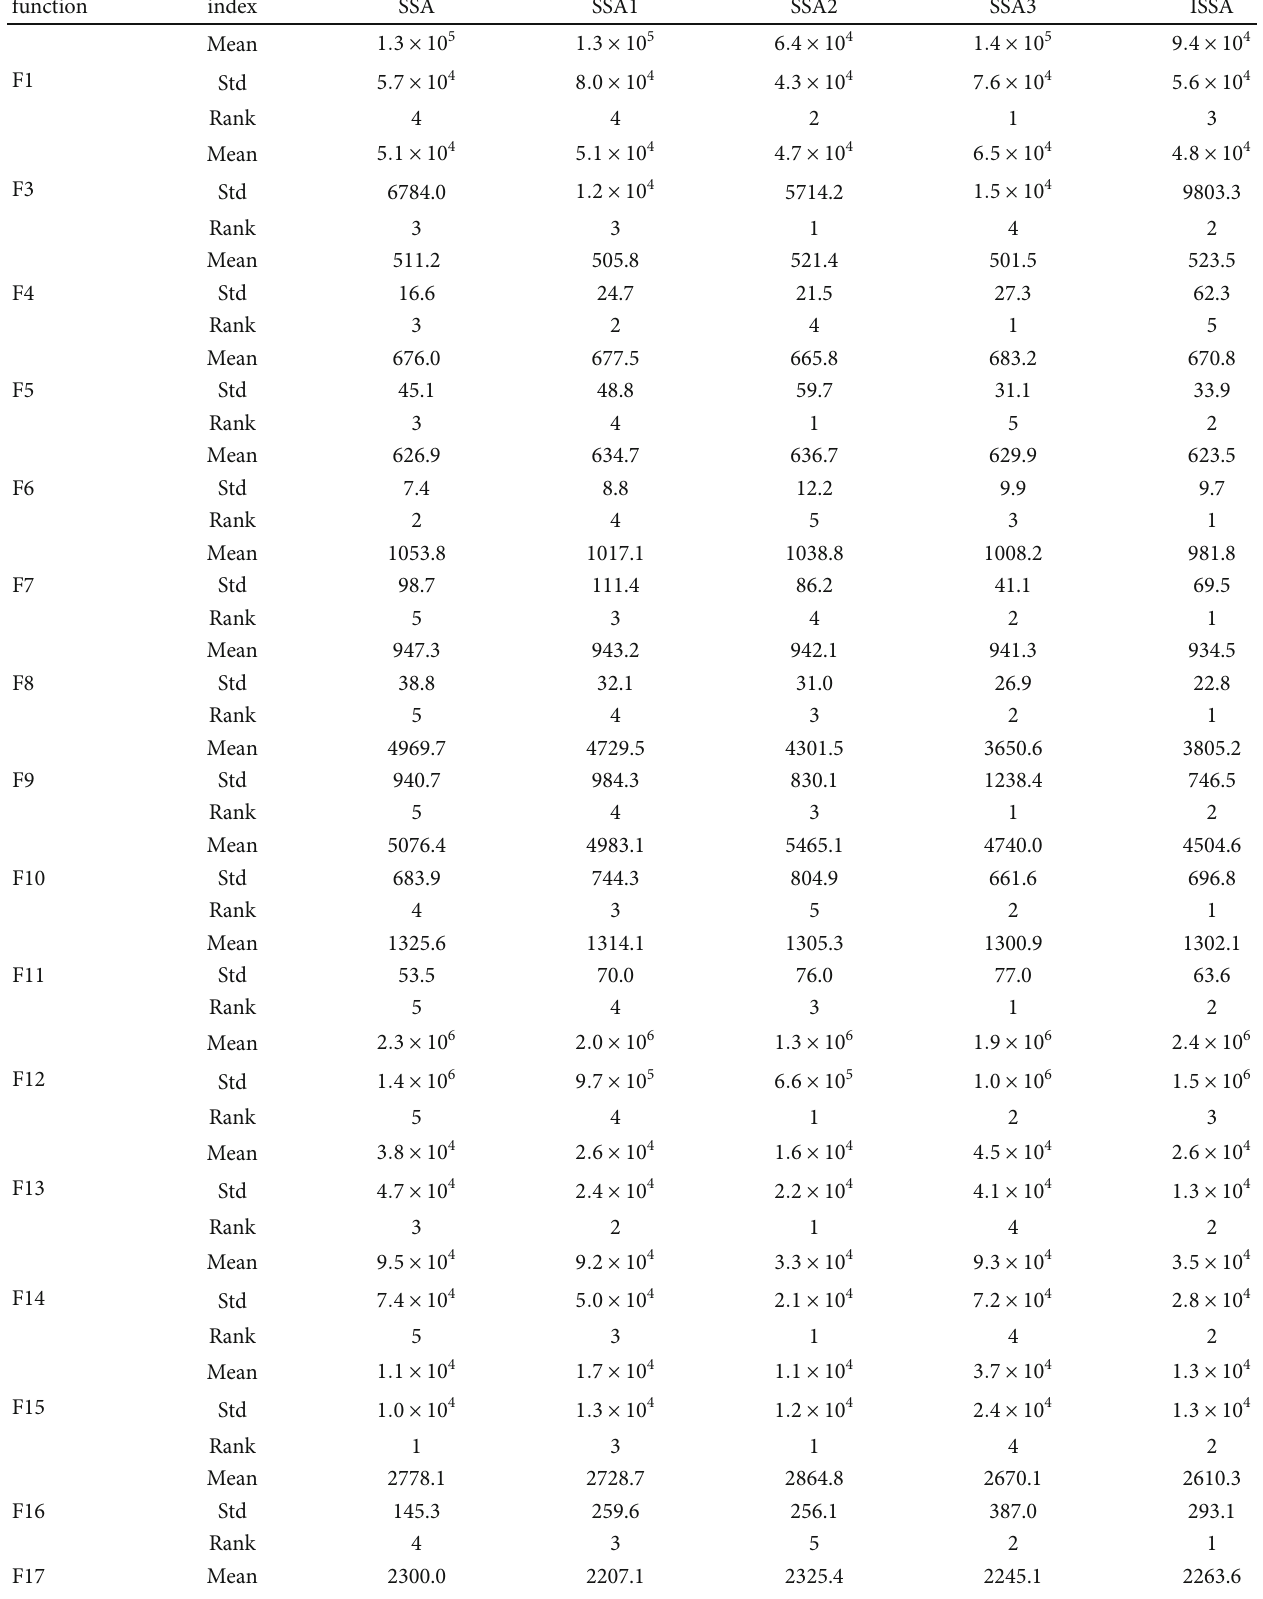
Table 1: Ablation